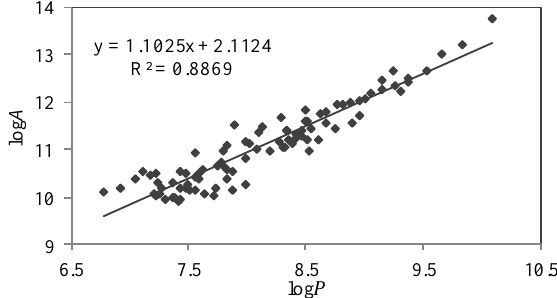
Figure 3. Plots of log A － log P of orchard